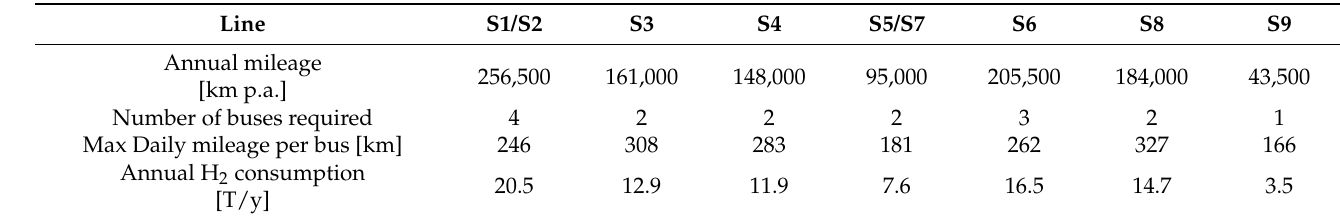
Table 7. Summary of results generated by the model.